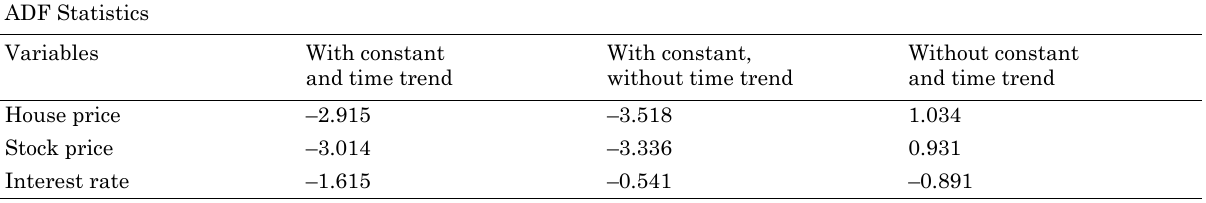
Table 2. ADf unit root test on house price, stock price, and interest rate ADf Statistics